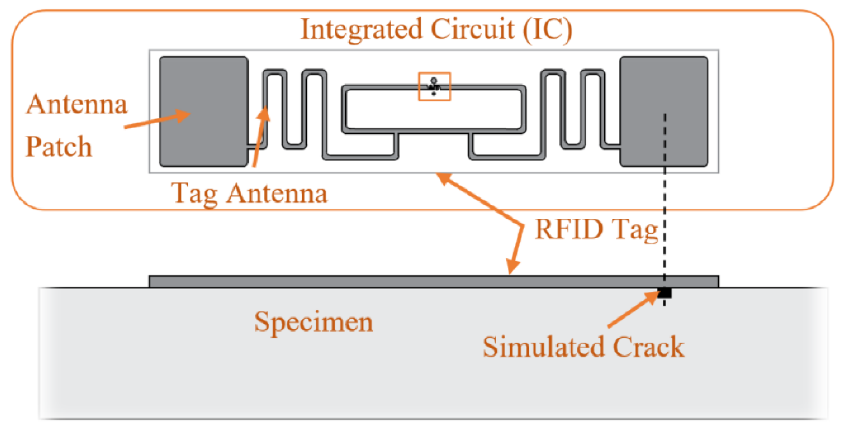
Figure 14. The commercial UHF RFID tag ALN-9662 (reproduced with permission from Reference